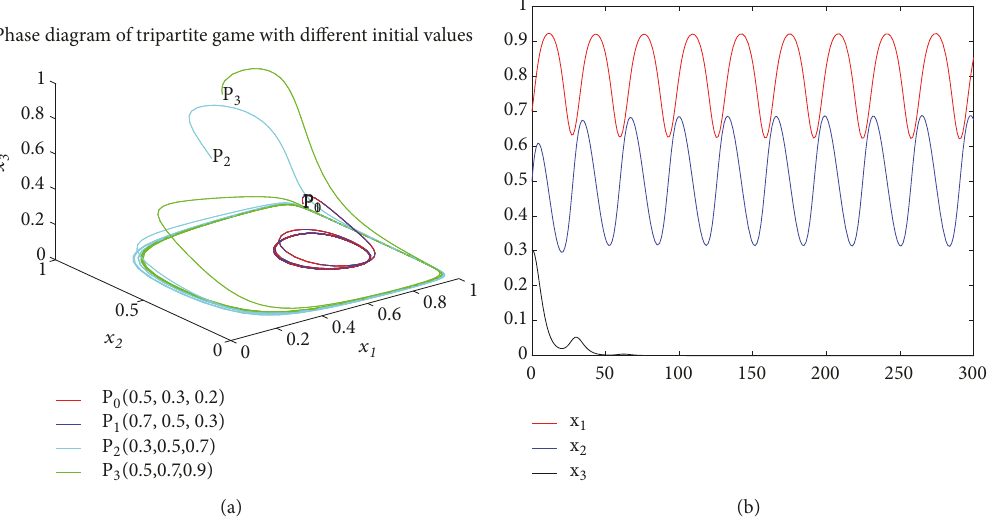
Figure 1: Phasegraph of dynamical system (1) and time series diagram of players’ strategyselectionprobabilities. Values of model parameters: (𝑐 ,𝑐 ,𝑐 ,𝑓 , 𝑓 ) = (0.5,0.2,0.3, 1,1.2) 1 2 3 1 2